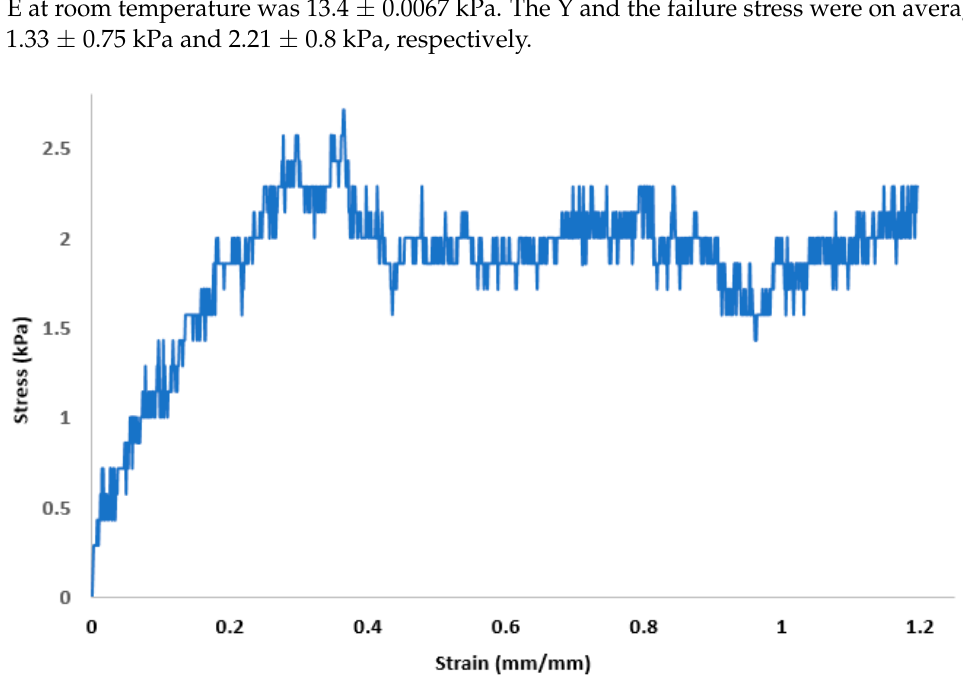
Figure 4. Tensile stress versus strain curve of retinal specimens at room temperature.